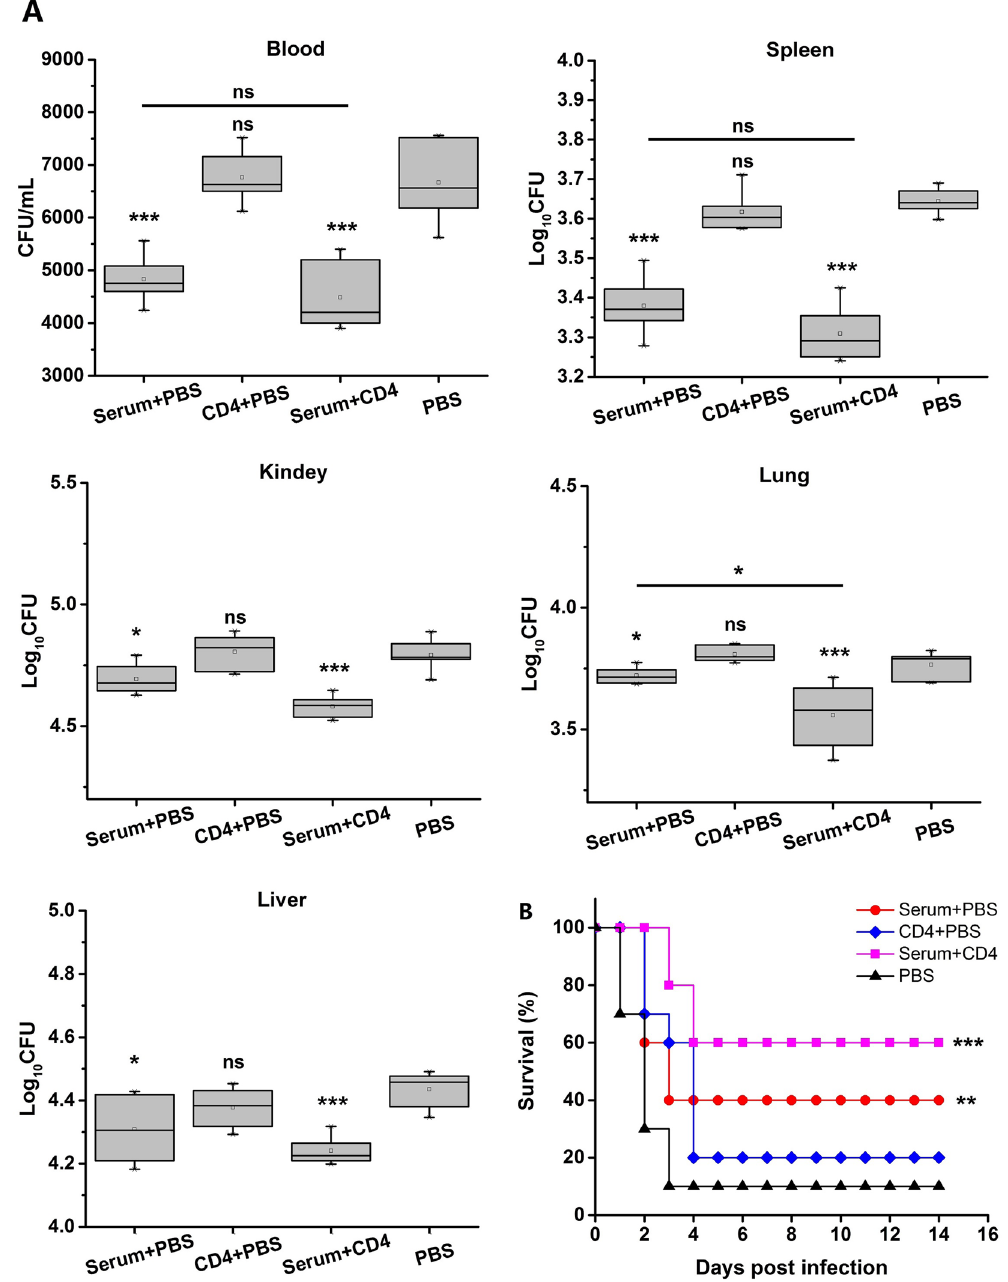
Figure 6. Passive immunization used MntC-specific CD4 + T cells (and sera). One day before infection, 300 µ L MntC-specific sera or (and) 1 × 10 6 CD4 + T cells per mouse were passively immunized via the intraperitoneal route, with isometric PBS as negative control. ( A ) Quantitative bacteriology was performed in organs. ( B ) Survival was monitored for 14 days. Significant differences were indicated by ( * P < 0.05), ( ** P < 0.01) and ( *** P <